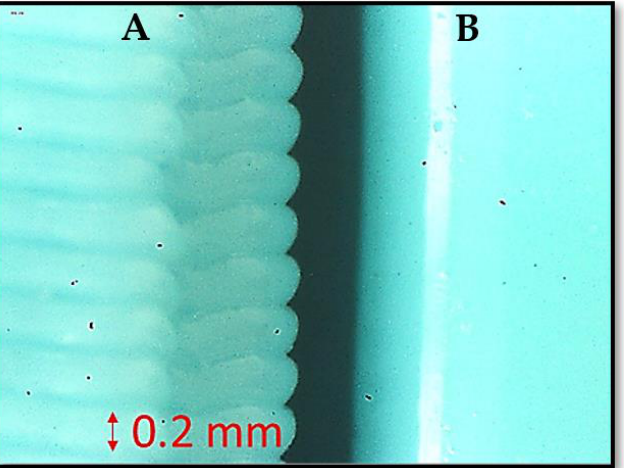
Figure 1. Effect of vapor smoothing, ( A ) the surface as printed, ( B ) same surface after chemical smoothing.